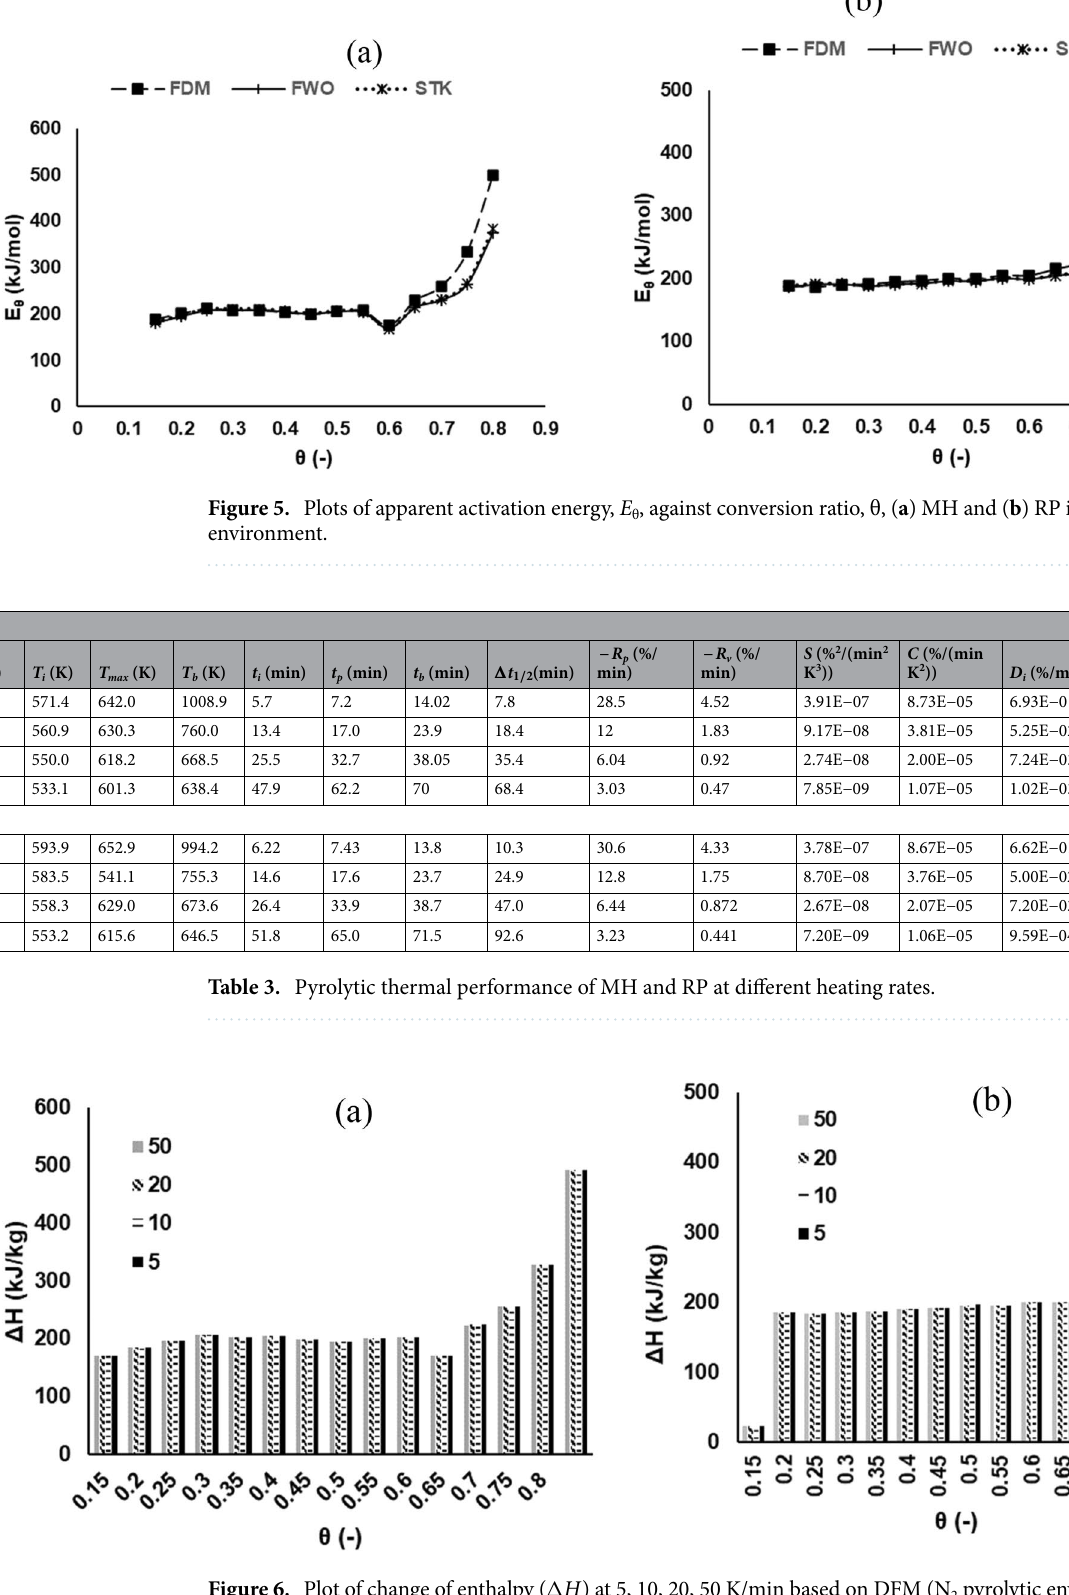
Figure 6. Plot of change of enthalpy ( (cid:31) H ) at 5, 10, 20, 50 K/min based on DFM (N 2 pyrolytic environment) for ( a ) MH and ( b ) RP thermal